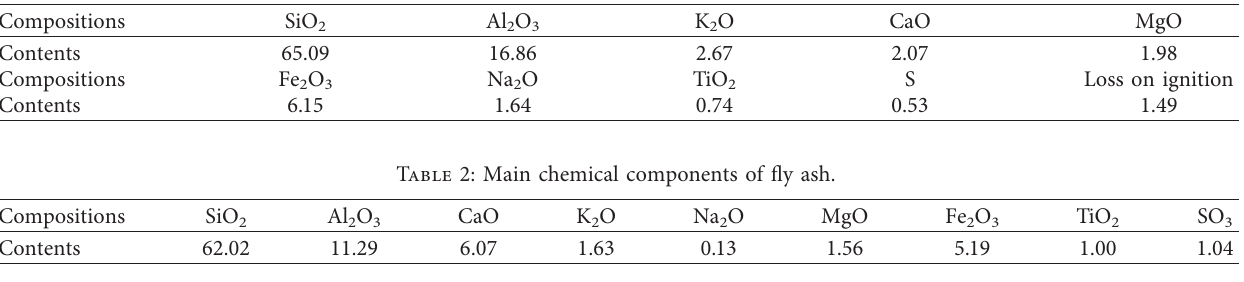
Table 1: Analysis results of main chemical components of coal gangue (%).